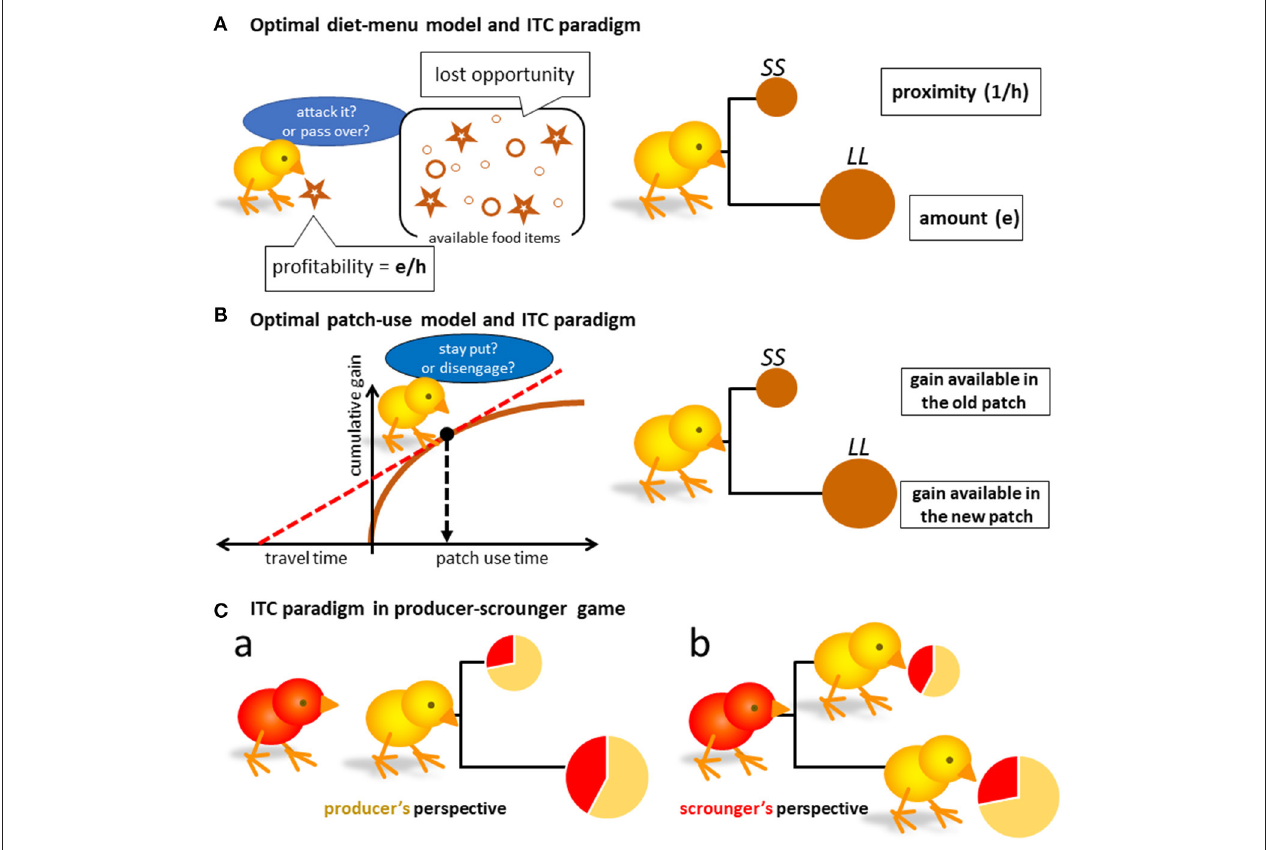
FIGURE 1 | Possible isomorphism between optimal foraging theories and the intertemporal choice paradigm (A,B) , which represent the optimal diet-menu model and the patch-use model, respectively. SS denotes a small and short delay reward, and LL a large and long delay alternative. Though the menu model (A) can be translated to the intertemporal choice (ITC) paradigm, the latter patch-use behavior cannot. In addition to the classical frameworks of optimal theories, we must address to the social foraging situation ( C a,b) to understand what the results of ITC tests could mean in terms of